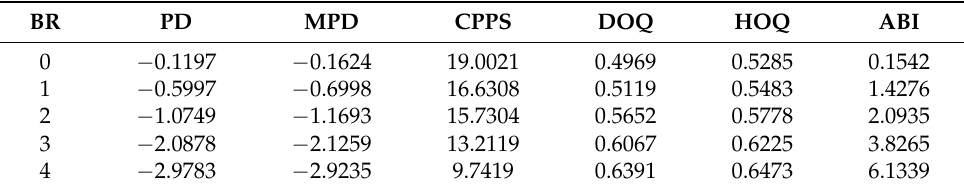
Table 1. Descriptive outcomes: Average values for different perceptual ratings of breathiness. BR: breathiness rating, PD: Pitch Difference, MPD: Pitch Difference in Mel scale, CPPS: Smoothed Cepstral Peak Prominence, DOQ: Open Quotient with DECOM method, HOQ: Open Quotient with Howard method.